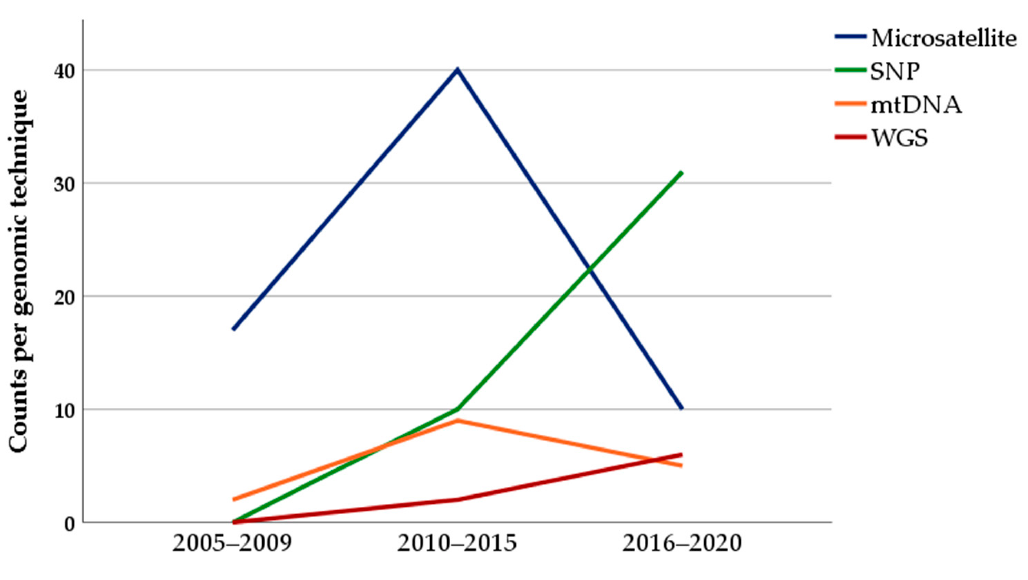
Figure 2. Development of the use of microsatellite, SNP-arrays, mtDNA analysis and whole-genome sequencing (WGS) for genotyping local farm animal breeds between 2005 and 2020 (n = 133 included studies).